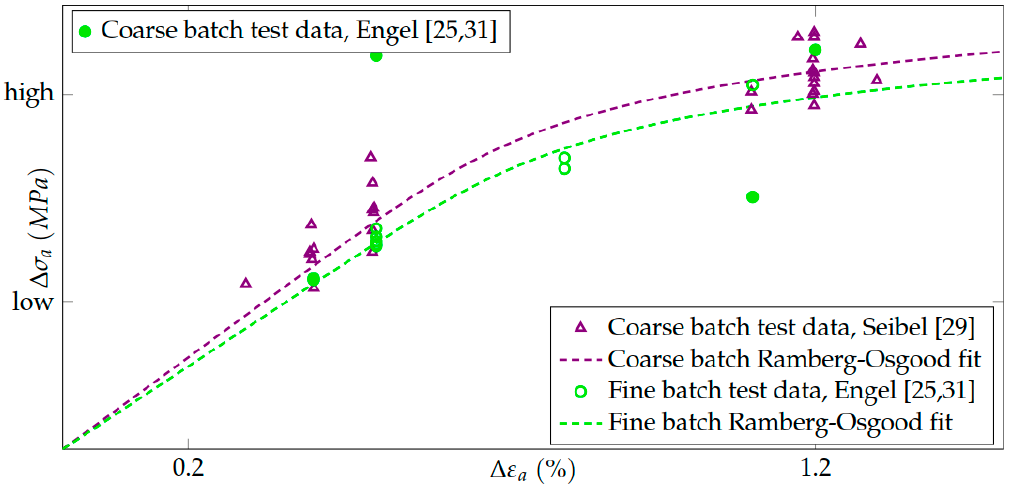
Figure 6. Stabilized cyclic stress response data and respective Ramberg-Osgood calibration curve for coarse grain batch and fine grain